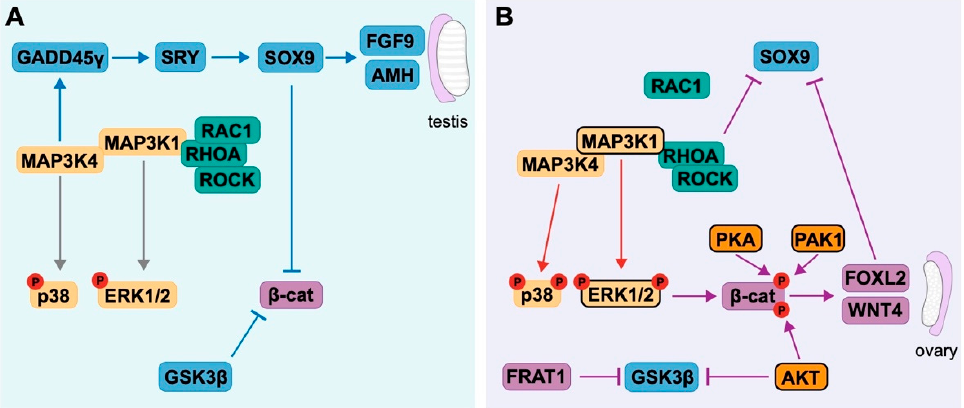
Figure 3. The influence of mitogen-activated protein kinase kinase kinase (MAP3K) cascades on gonad di ff erentiation and potential non-genomic targets of oestrogen. Pro-testis factors are shown in blue and pro-ovary factors in purple. ( A ) In testis development, MAP3K4 together with growth arrest and DNA damage-inducible protein γ (GADD45 γ ) promotes expression of SRY , which in turn promotes SOX9 and testis development. Together with SOX9, glycogen synthase kinase 3 β (GSK3 β ) inhibits β -catenin activity, blocking ovarian development. ( B ) In ovarian development, activation of MAP3K1 and MAP3K4 and increased binding of MAP3K1 to RHOA / ROCK promotes phosphorylation of p38 and ERK1 / 2. Activated ERK1 / 2 and FRAT1-mediated inhibition of GSK3 β promotes stabilisation of β -catenin and expression of ovarian genes FOXL2 and WNT4 . Phosphorylation of β -catenin by AKT serine / threonine kinase (AKT), protein kinase A (PKA), and p21 (RAC1) activated kinase 1 (PAK1) promotes its activity and AKT activation reduces the activity of GSK3 β . SOX9 is inhibited through the activity of β -catenin, FOXL2 and RHOA. Potential non-genomic targets of exogenous oestrogen that could promote granulosa cell fate are indicated by a black border. Adapted from Ostrer 2014 [141].